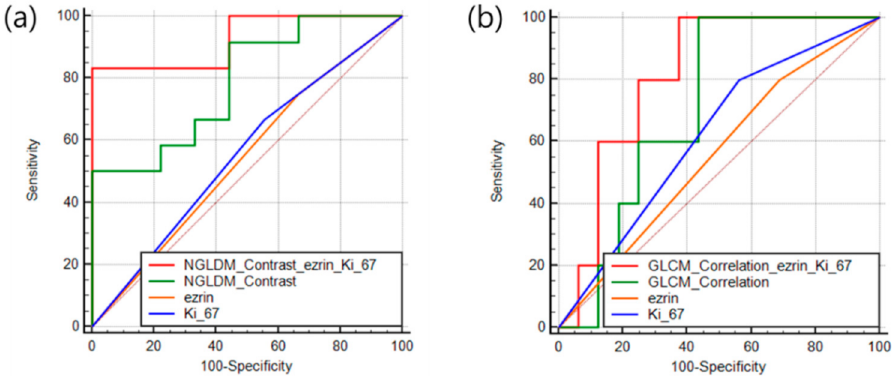
Figure 5. Receiver operating characteristic curves of the prediction features for patient outcomes. ( a ) Chemotherapy response. ( b )